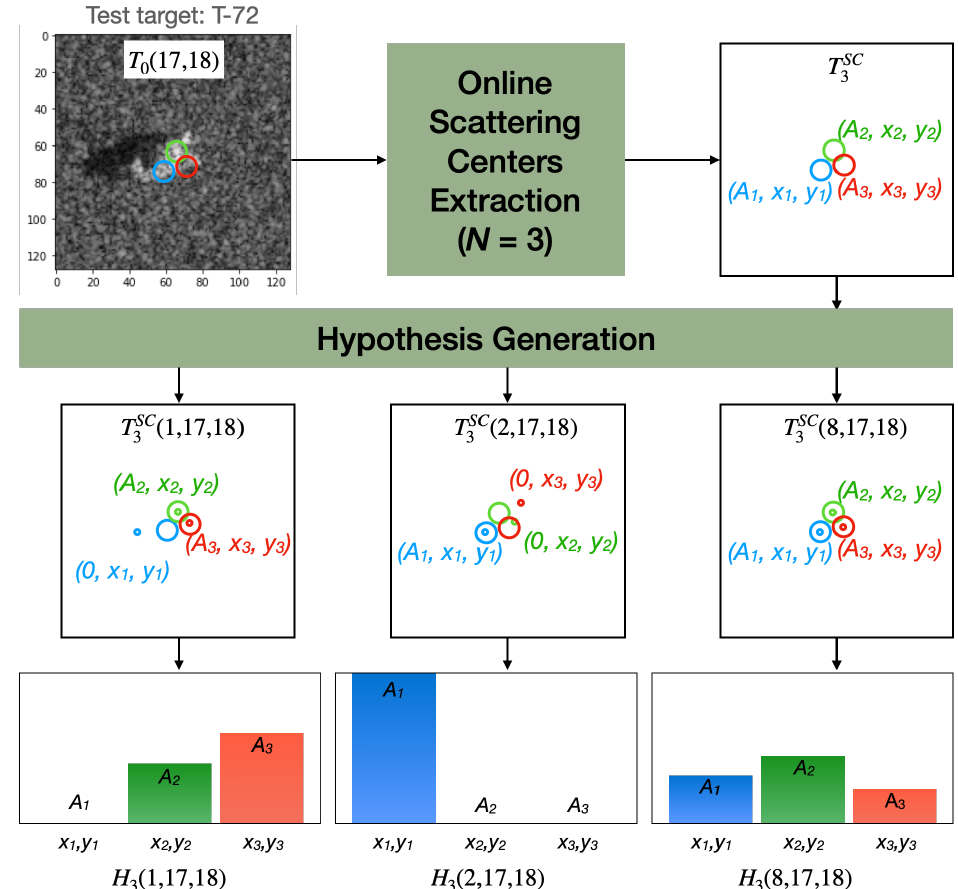
Figure 11. Illustrated example of the three hypotheses generated by SC-based approach. Each hypothesis (BMP-2, BTR-70, and T-72 classes) was generated by extracting three scattering centers from the T-72 test target accordingly to the respective class